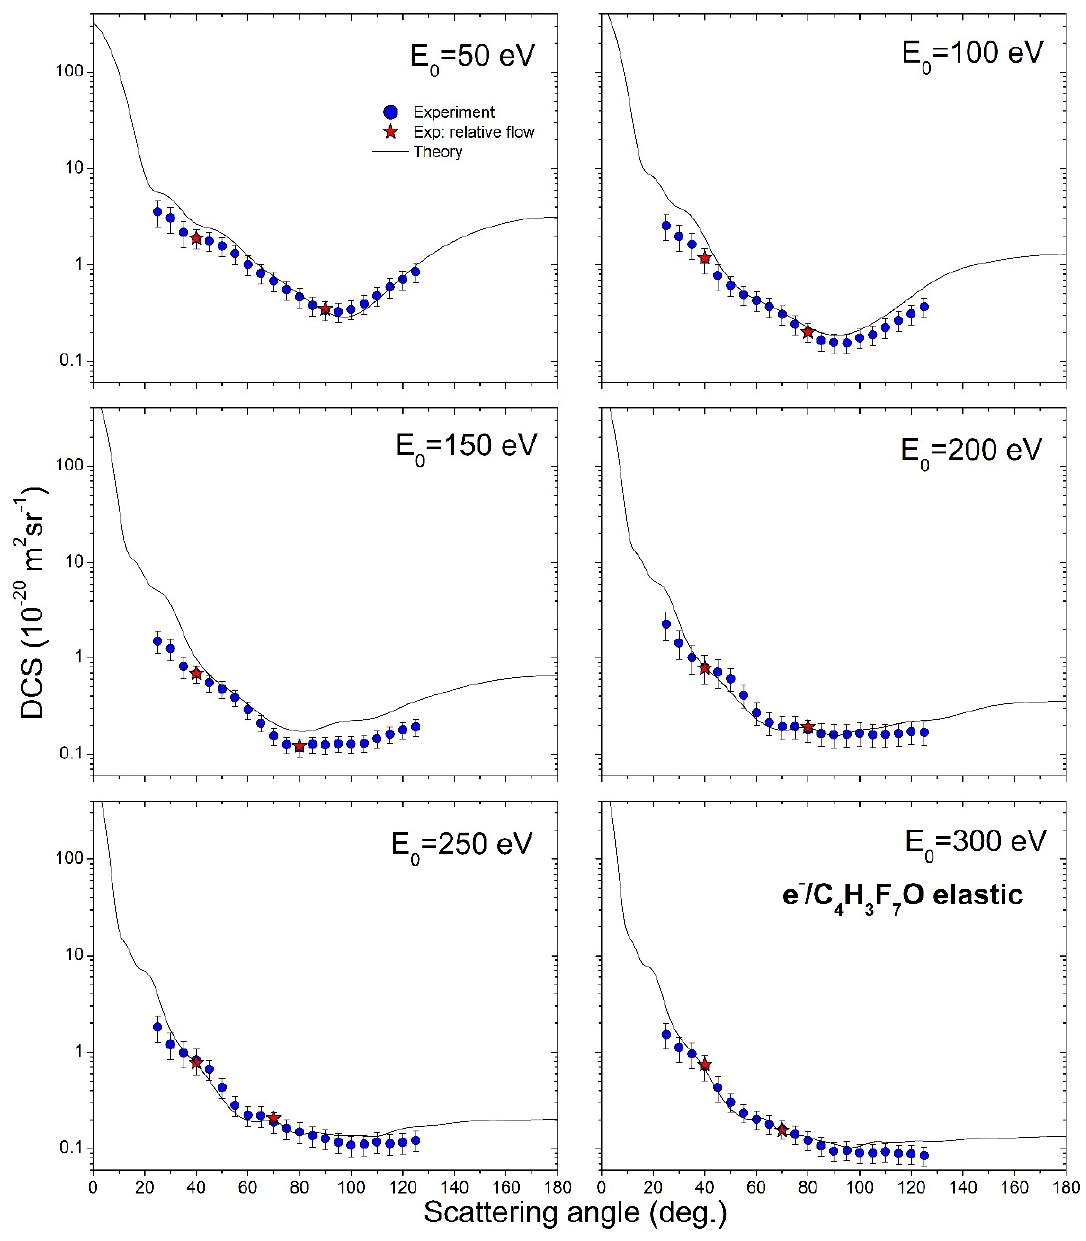
Figure 3. Angularly dependent differential cross-sections for elastic electron scattering from sevoflurane molecule, for six incident electron energies, from 50 eV to 300 eV. The present results include: experiment (blue circles), relative flow absolute data (red stars) and theory (full line).